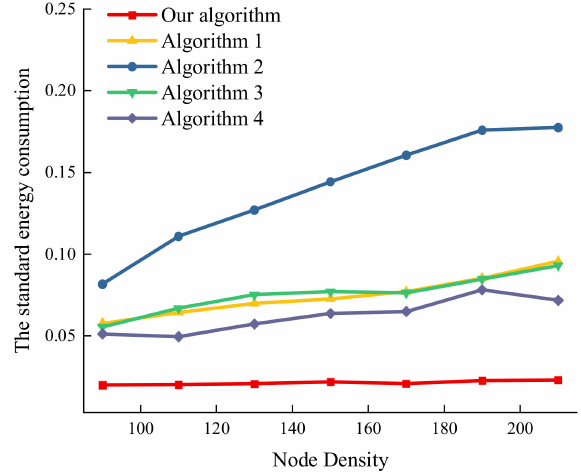
Figure 3. Network energy efficiency under a different number of nodes.